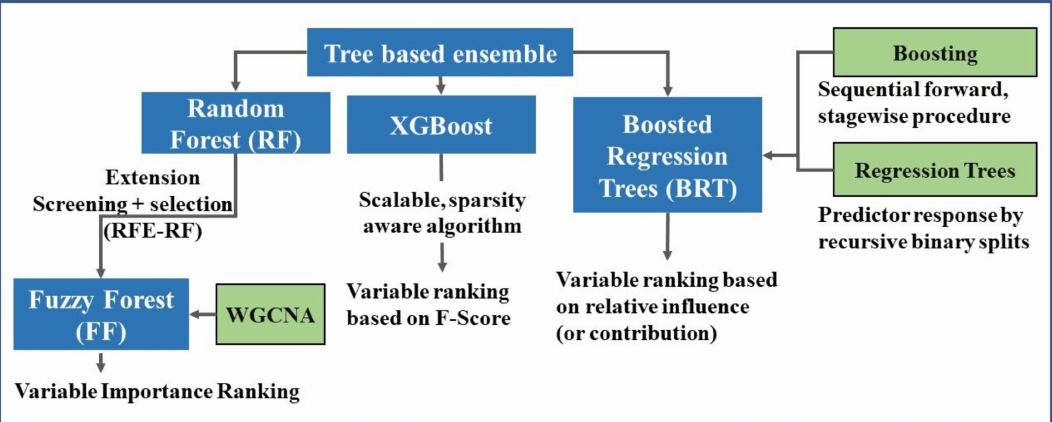
Figure 4. Tree-based ensemble machine learning models implemented in this study for selecting meteorological variables influencing bushfire